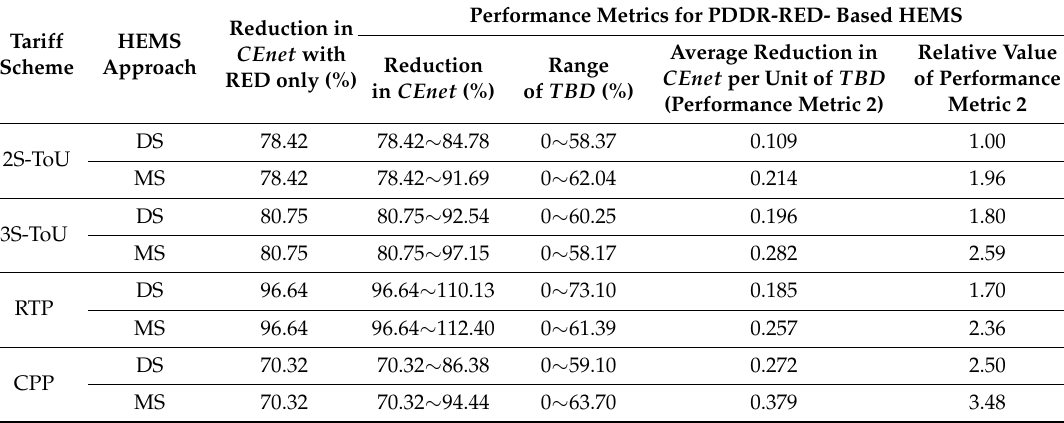
Table 9. Performance metrics of DWS-PSO for PDDR-RED-based HEMS.